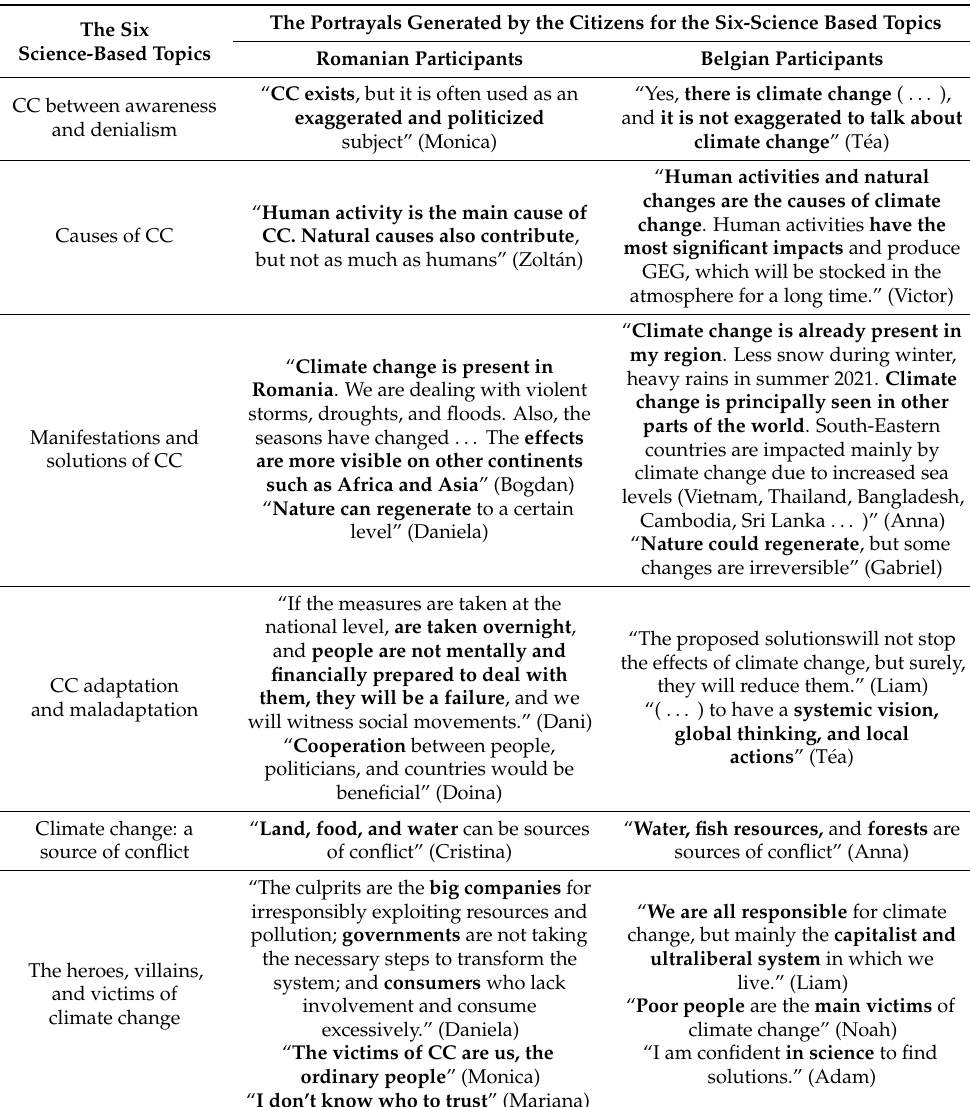
Table 4. The portrayals generated by the citizens for the six-science based